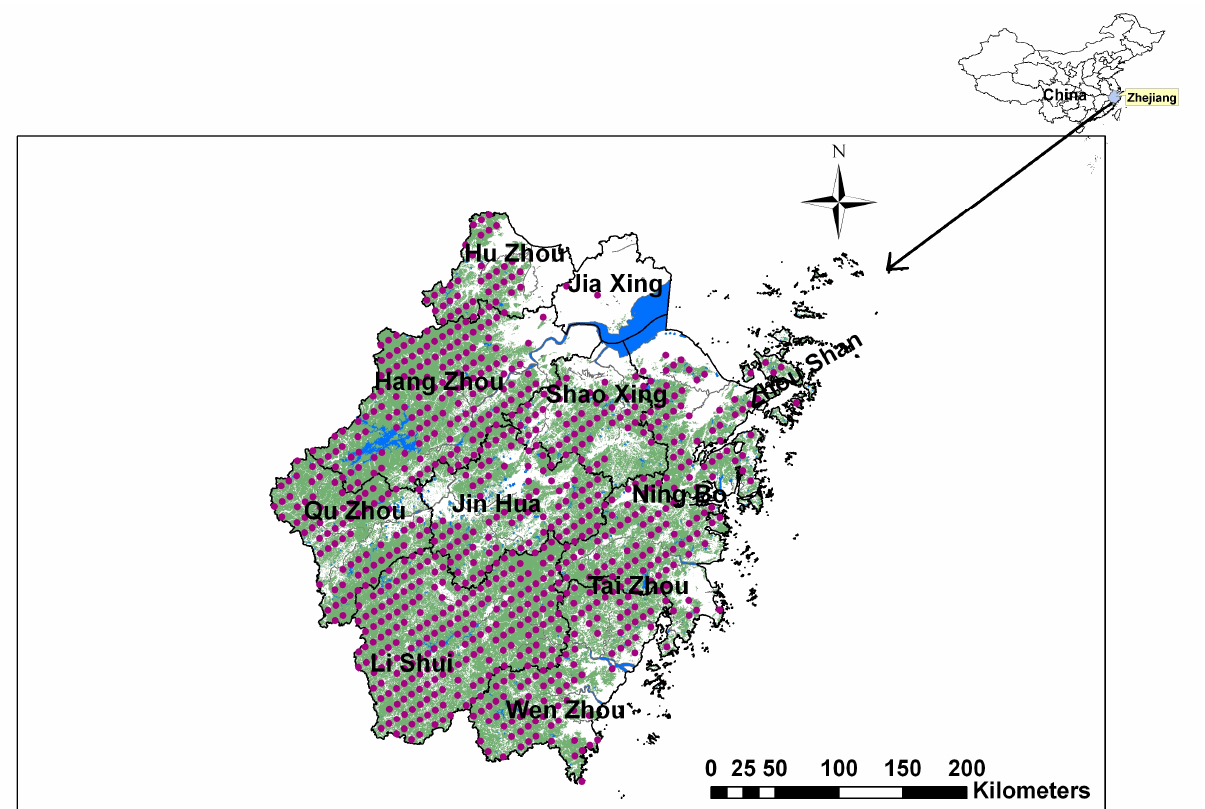
Figure 1. Location of the study area and